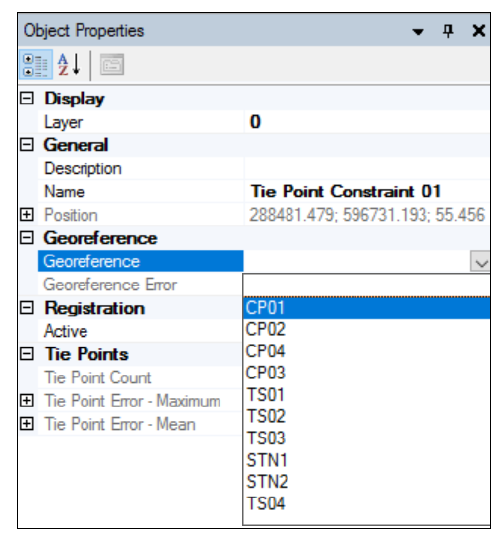
Figure 31. The corresponding points that were